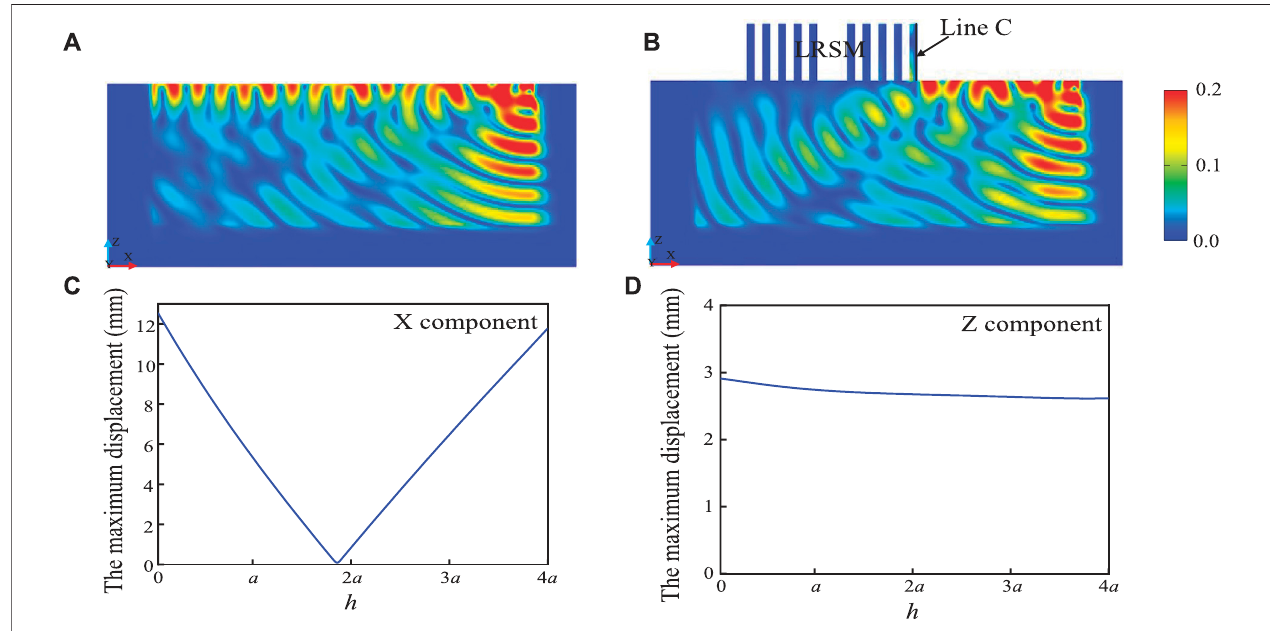
FIGURE12| SchematicdiagramofsurfacewavepropagationinXZplane: (A) WithoutLRSM; (B) withLRSM-2; (C) vibrationdisplacementvalueofXcomponentat line C; (D) vibration displacement value of Z component at line (C)